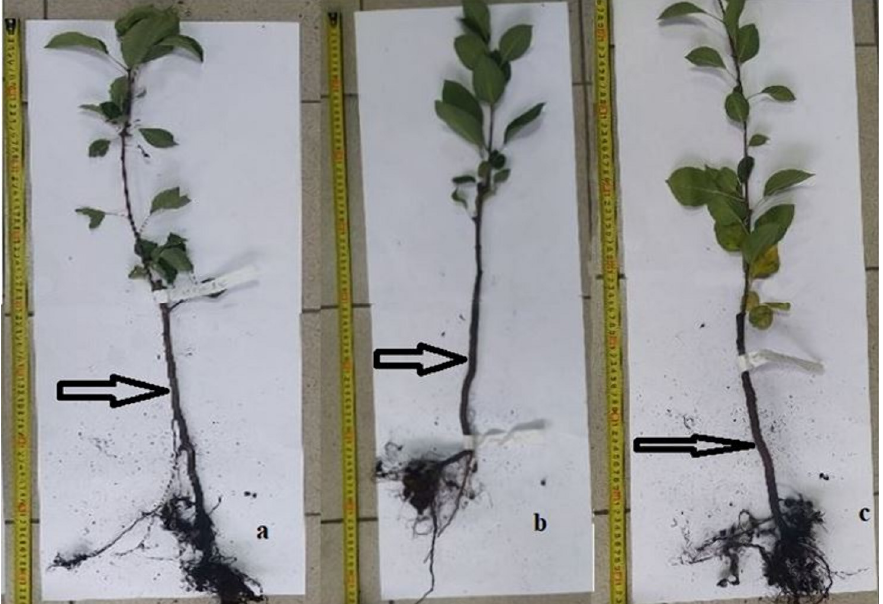
Figure 8. Visual comparison of young trees development after 6 months of growth; ( а ) 30 s DBD CAP, ( b ) control, ( с ) PTS:DW. The arrow indicates the places of grafting.